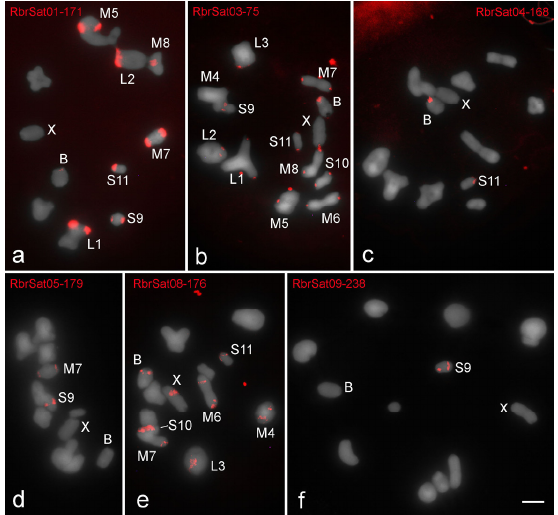
Figure 2. Fluorescent in situ hybridization (FISH) mapping on metaphase I of satDNAs identified in the genome of R. brasiliensis . The distinct satDNAs families are indicated. Chromosomes with signals, X and B chromosomes are identified. Note the presence on B chromosome of signals for ( a ) RbrSat01-171 (shared with some A chromosomes), ( b ) RbrSat03-36 (shared with all A chromosomes), ( c ) RbrSat04-168 (shared exclusively with pair S11), and ( e ) RbrSat08-176 (shared with some A chromosomes). For satDNAs ( d ) RbrSat05-179 and ( f ) RbrSat09-238 no signals were observed in B chromosome. Bar = 5 μ m.